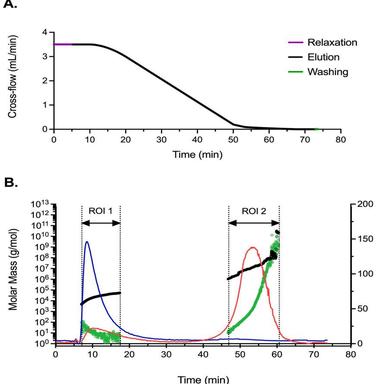
Oxidized alginate with 50% target degree of oxidation (DO50): A. characteristic elution pattern (75 min); B. AF4 fractogram: detector signal from MALS at 90◦ light scattering (red line), differential refractive index dRI (blue line), molar mass distribution (black circle ○, g/mol) and root-mean-square radius distribution (green circle ○, nm) versus the elution time (min). Two ROIs with distinctive peaks are detected and correspond to the soluble oxidized alginate (22 kDa, ROI 1) and aggregates ((accounting